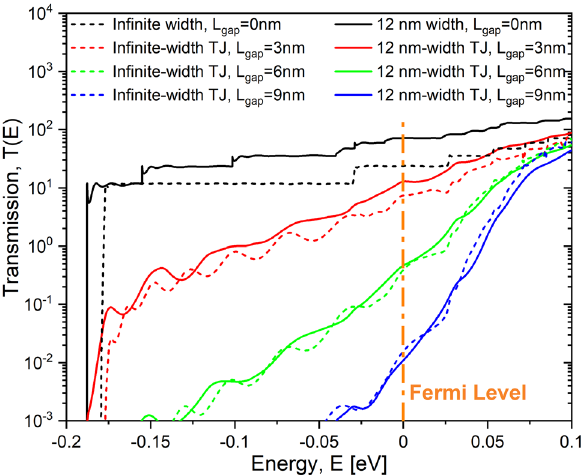
Figure 5. Electronic transmission for Si:P δ -layer systems. It shows a comparison of the transmission function (logarithmic scale) for an applied voltage of 1.0 mV for infinite and 12 nm-width δ -layer devices. The transmission function for the infinite-width δ -layer is normalized to a width of the device of W comparison purpose. N